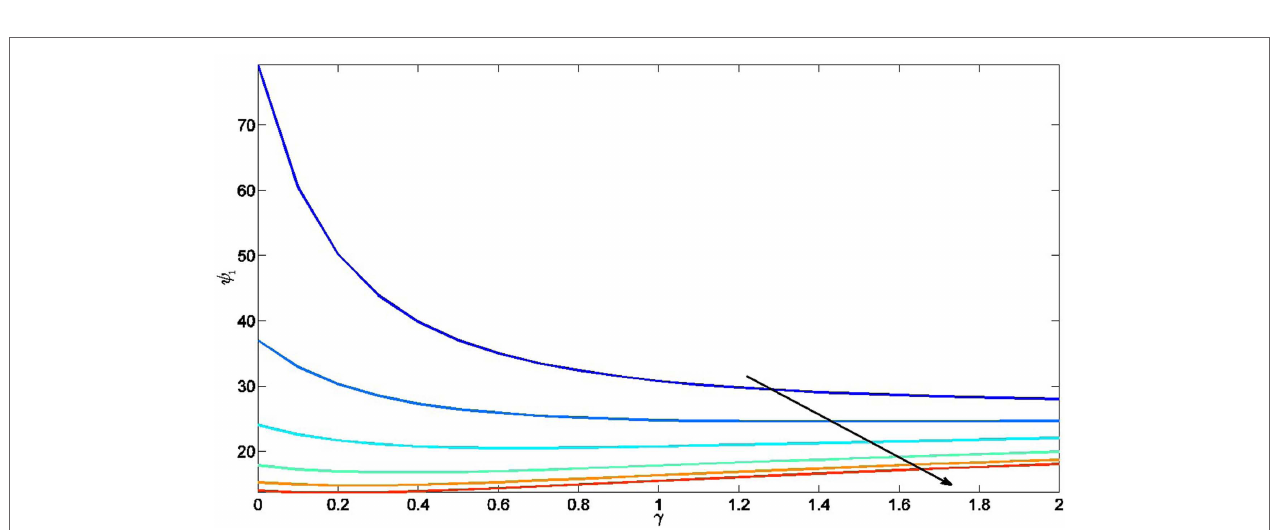
Fr ontiers in Robotics and AI |